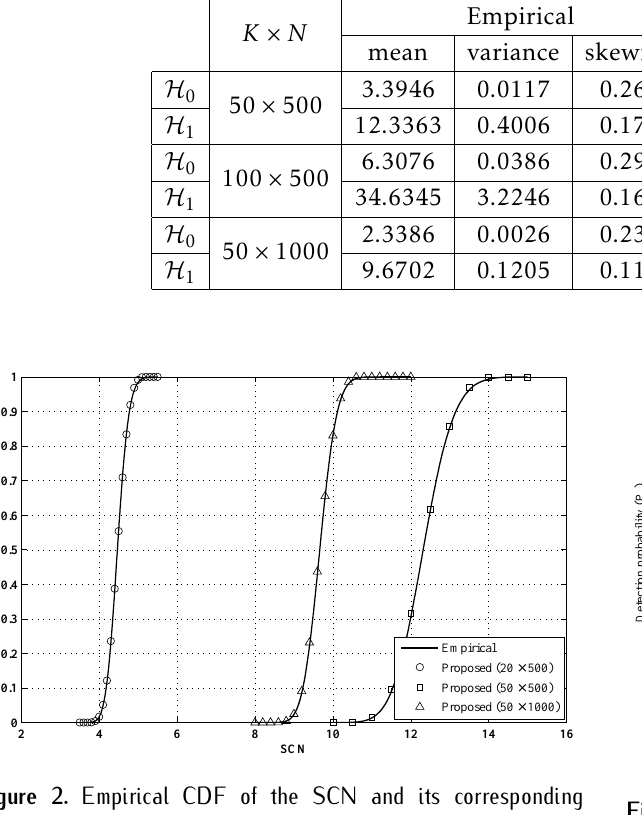
P f a is fixed to 0 . 001 and the threshold is calculated using (56) for di ff erent values of K = { 20 , 25 , 30 } and N = { 300 , 400 , 500 } . Results show the accuracy of